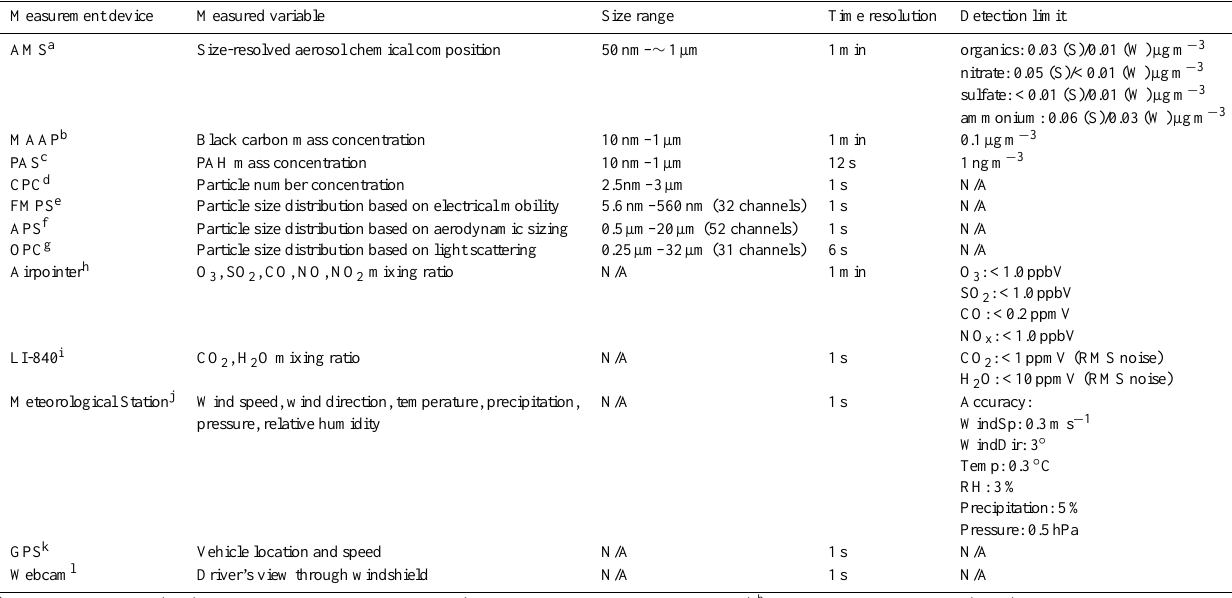
Table 1. Summary of measurement devices – including information about measured variables, size range, time resolution and detection limit – installed in the mobile laboratory MoLa (Max Planck Institute for Chemistry) during the summer and winter MEGAPOLI field campaigns. AMS detection limits (using the method described in Drewnick et al., 2009) were calculated for summer (S) and winter field campaign (W) separately, because the AMS detection limit can change over